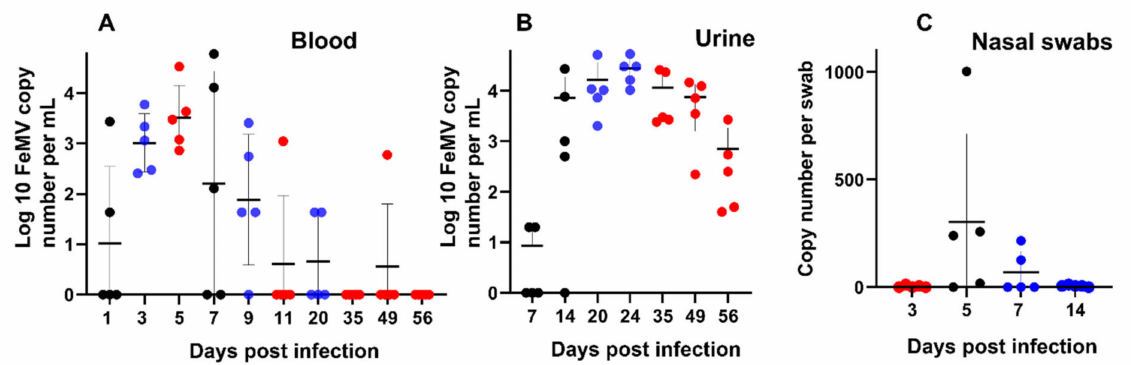
Figure 4. Virus replication and shedding. ( A ) FeMV viremia (FeMV RNA copy numbers/mL of plasma) in cats after experimental infection with FeMV-GT2. ( B ) FeMV excretion in urine (FeMV RNA copy numbers/mL of urine) in cats after experimental infection with FeMV-GT2. ( C ) FeMV excretion in nasal swabs. FeMV-RNA copy number per swab. Cats were infected at day 0. Individual samples are shown as dots. In each column, mean values with standard deviation are shown. Point colors refer to the groups and their associated sampling times (Table 1): black = group A, blue = group B, red = group